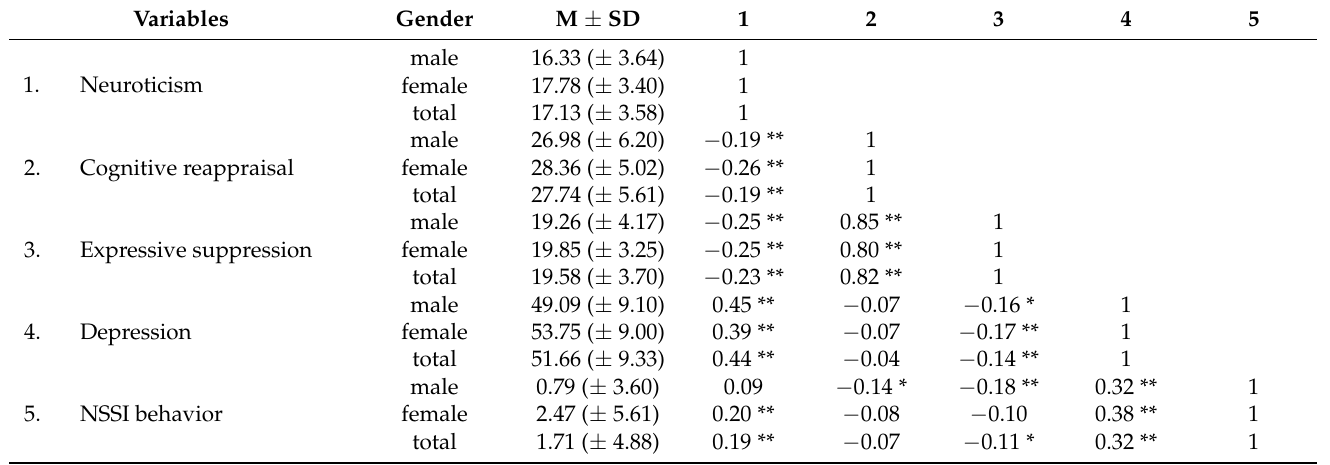
Table 1. Gender differences in variables and the correlation between